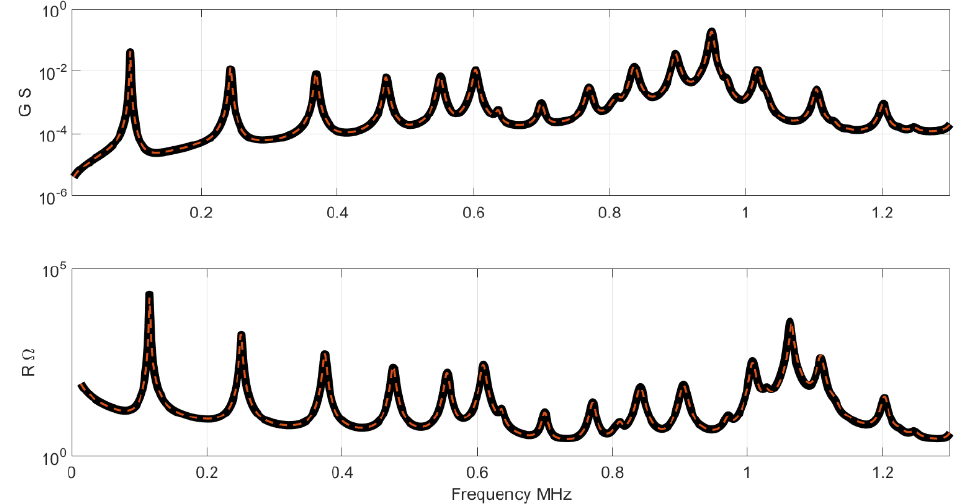
Figure 6. Results for conductance and resistance. The black curve is the impedance of the Test set, the red curve is the NN result.